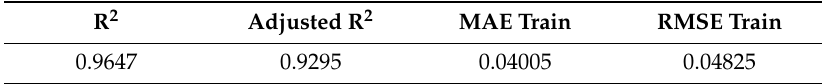
Table 5. Results of the R 2 , adjusted R 2 , and errors in predicting the Ni(II) remove e ffi ciency when using the quadratic regression model that is obtained.